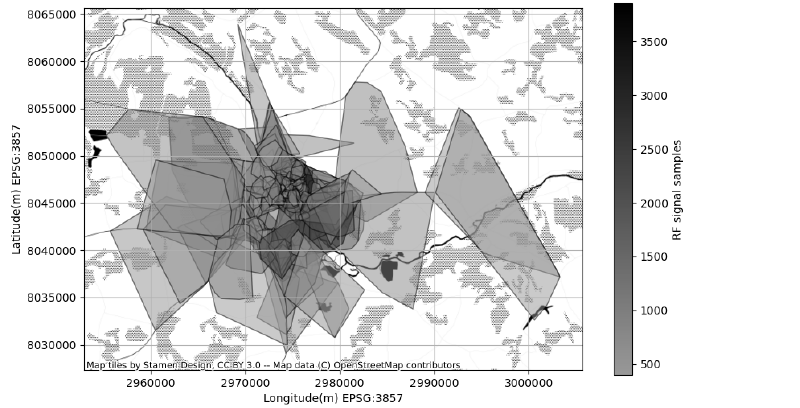
Figure 12. Coverage map modeled by 1-level polygons, allows to represent the overlaps of the cellular coverage areas; yet it does not allow to see the RF signal strength distribution within a cell’s